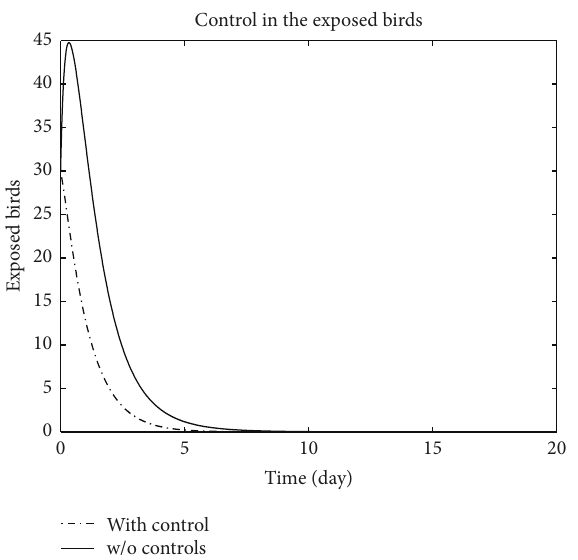
Figure 7: The plot represents the population of exposed birds with and without control.